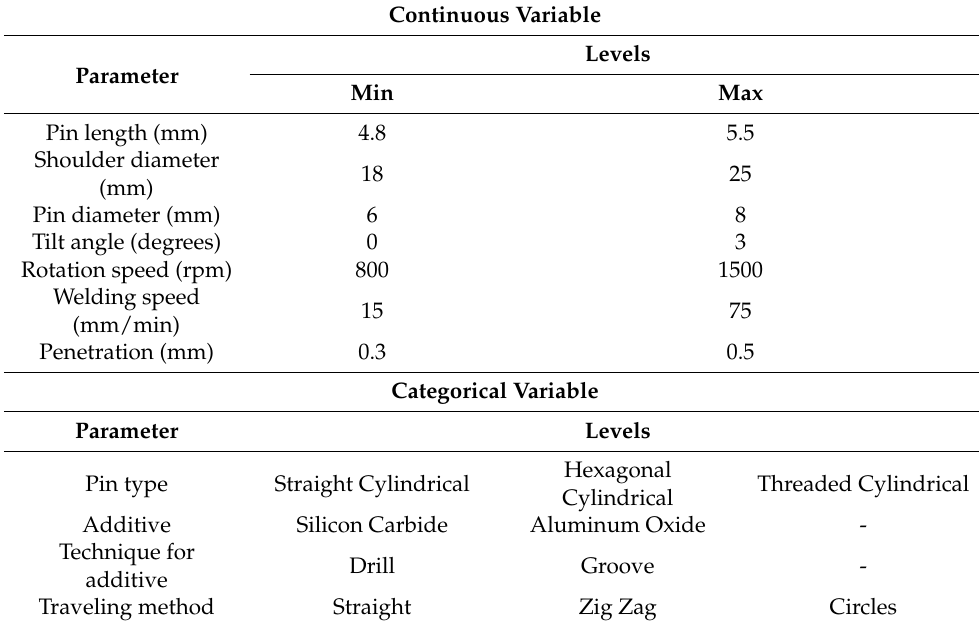
Table 4. Input parameters of FSW for testing and